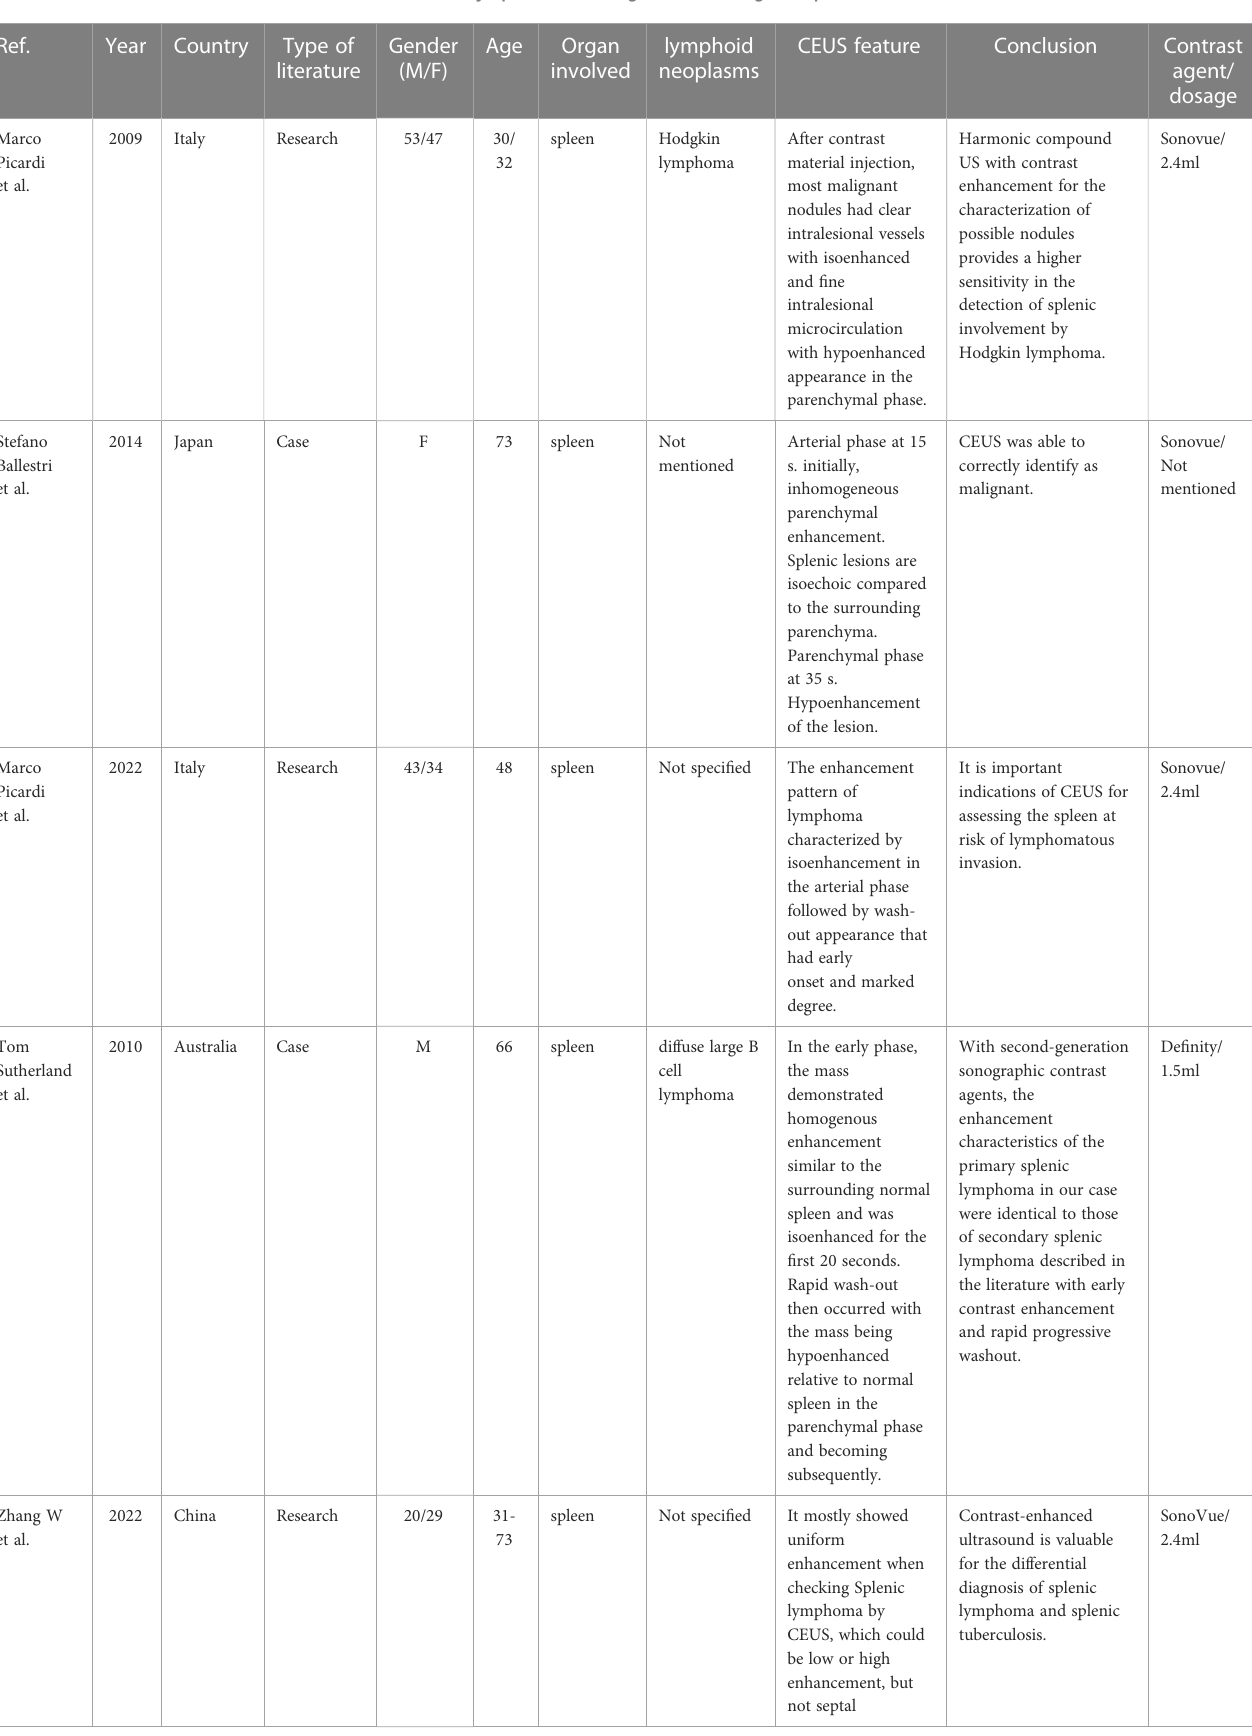
TABLE 2 Contrast-enhanced ultrasound characteristics of lymphoma involving extranodal organs reported in the literature.